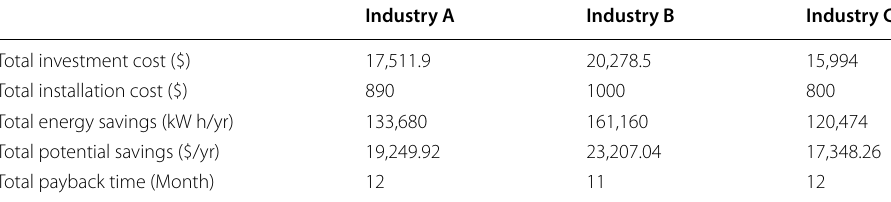
Table 8 Overall investment and saving on lighting fixtures Industry A Industry B